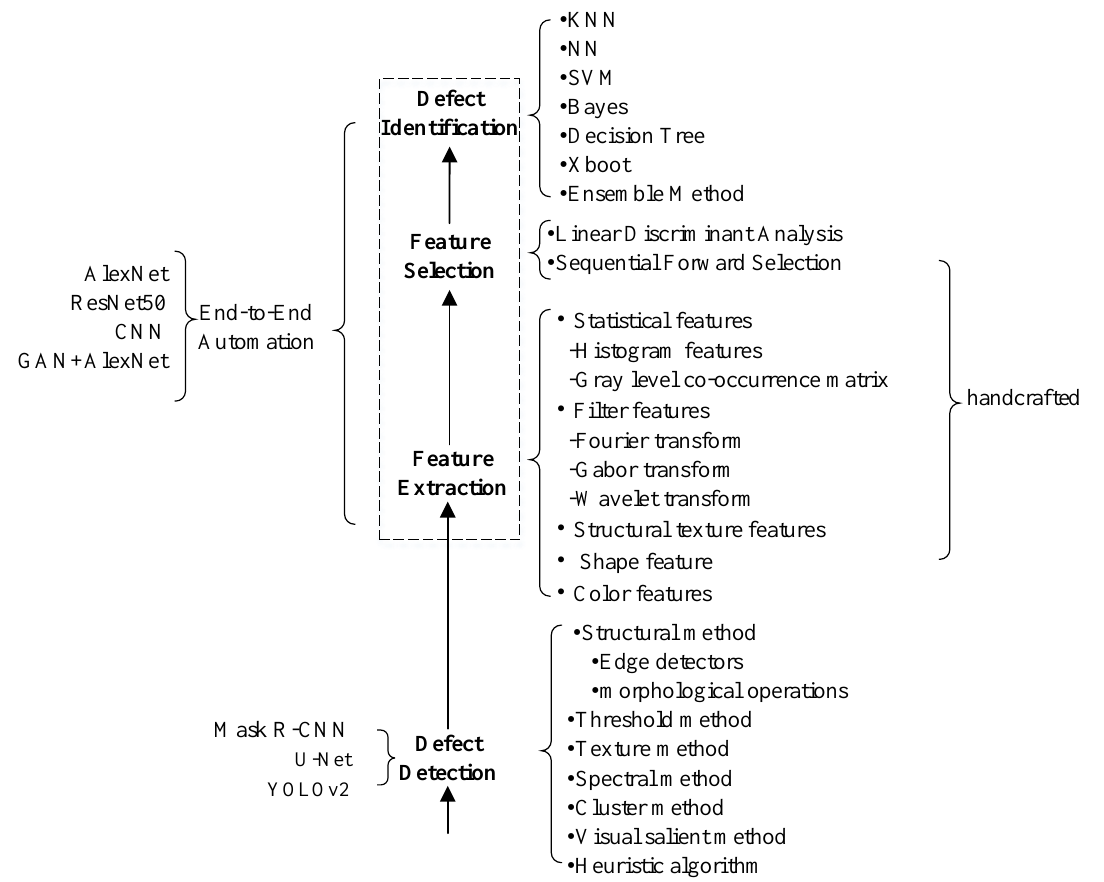
Figure 2. Methods used in leather surface visual defect inspection in previous literatures.